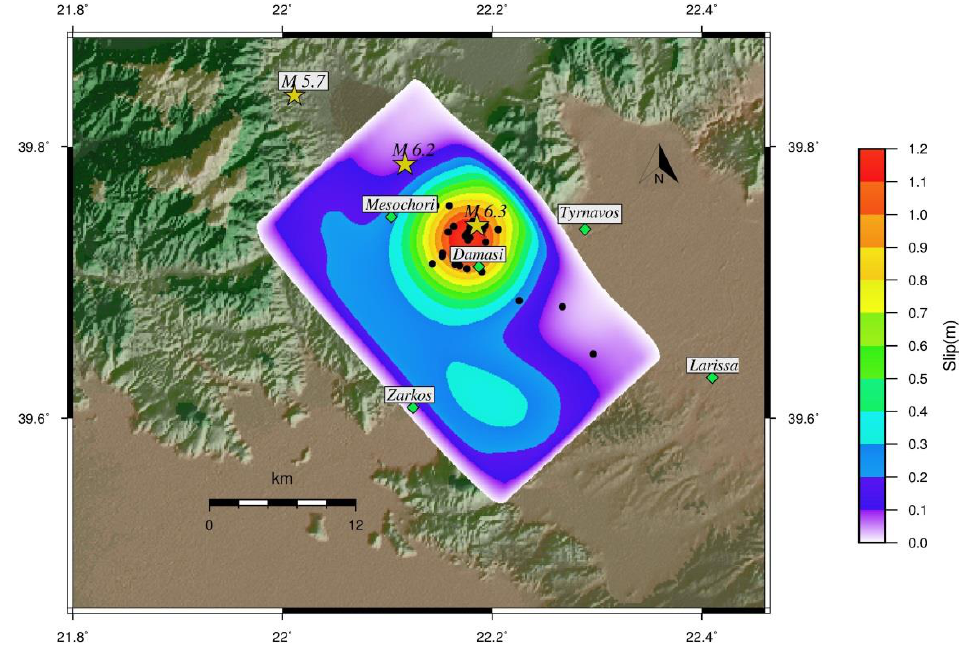
Figure 8. Horizontal projection of the slip distribution for the 3 March rupture. Stars from SE to NW show relocated epicenters of the first, second and third earthquakes; magnitudes determined in this study (see later sections). Black circles illustrate foreshocks recorded from 28th February to 3 March 2021; epicenters are from NOA’s determinations (http://bbnet.gein.noa.gr/HL/databases/ database, accessed on 15 May 2021).